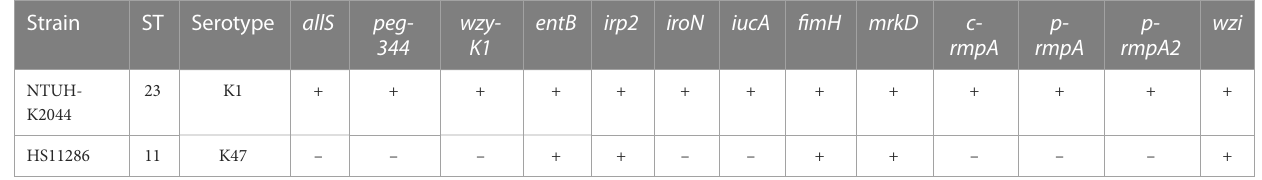
TABLE 1 Genetic backgrounds of NTUH-K2044 and